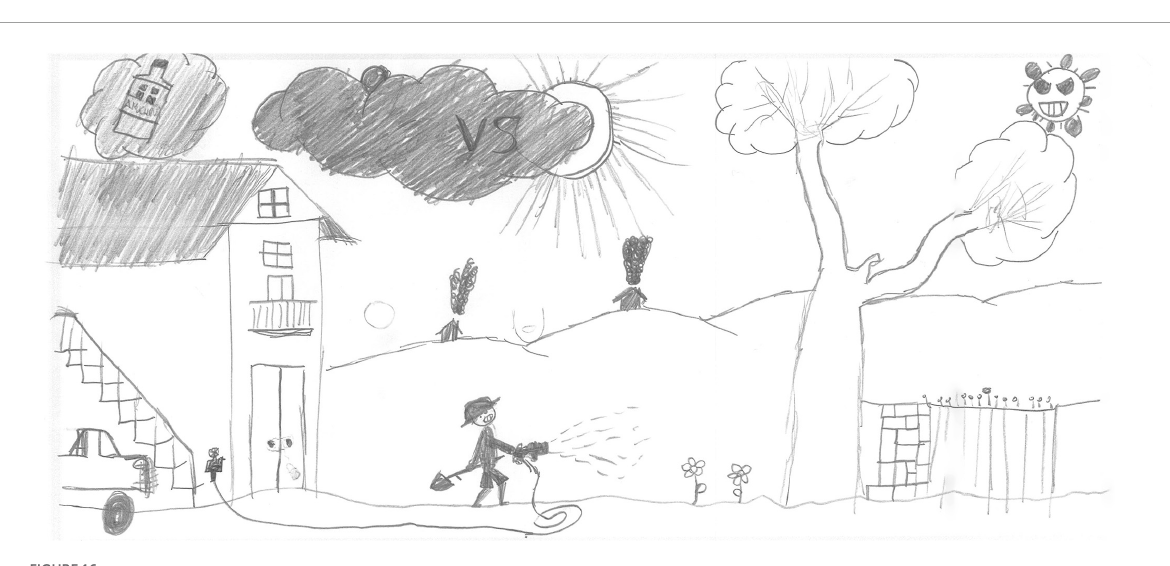
FIGURE16 Taking care of the garden (SS, Male, 11